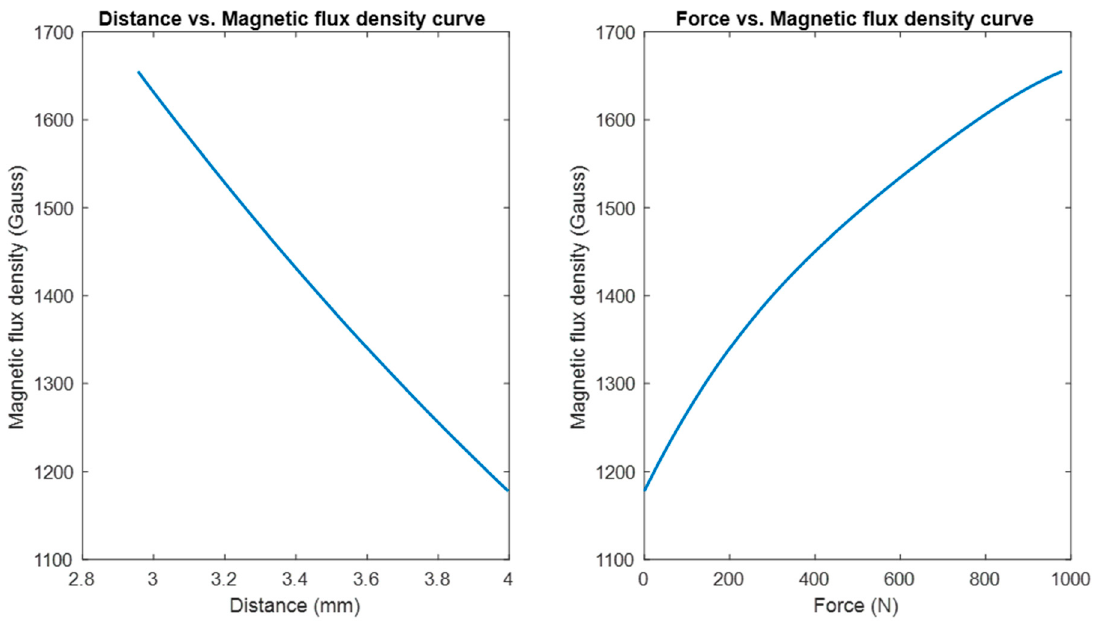
Figure 13. The change of magnetic flux density with respect to the relative distance between the